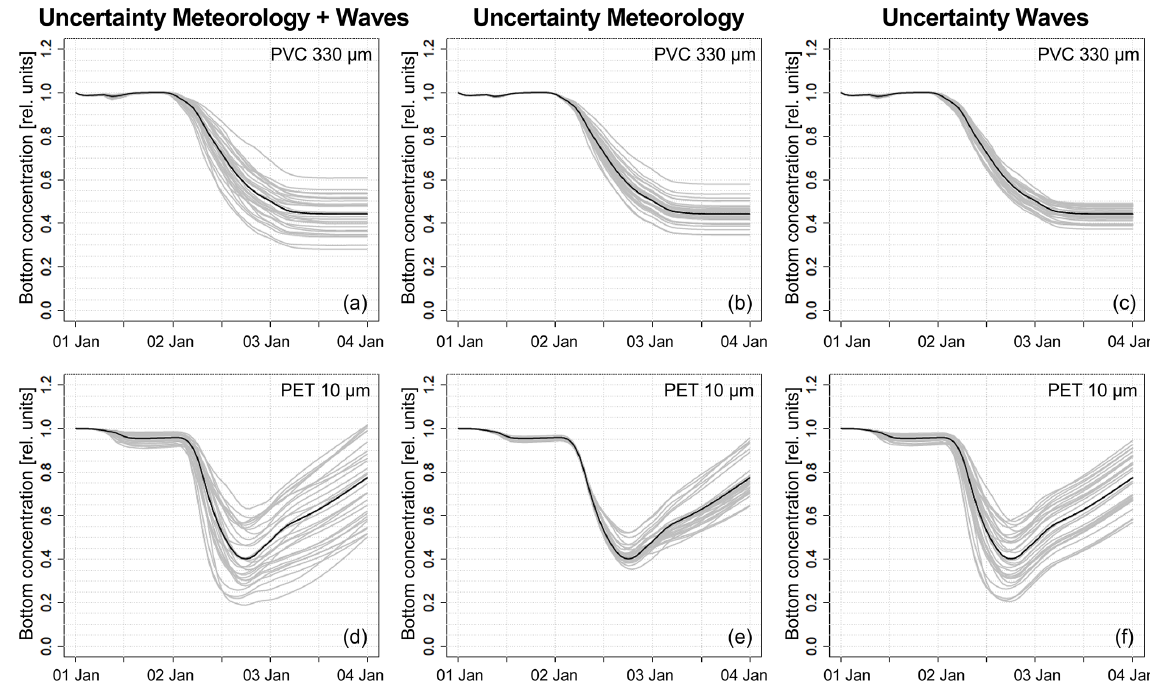
Figure 11. Spread of runs with varying atmospheric forcing and/or varying wave forcing for PVC with a 330µm diameter (a, b, c) and PET with a 10µm diameter (d, e, f) , for the bottom concentration at 57.69 ◦ N, 21.35 ◦ E (see Fig. 9) relative to the initial